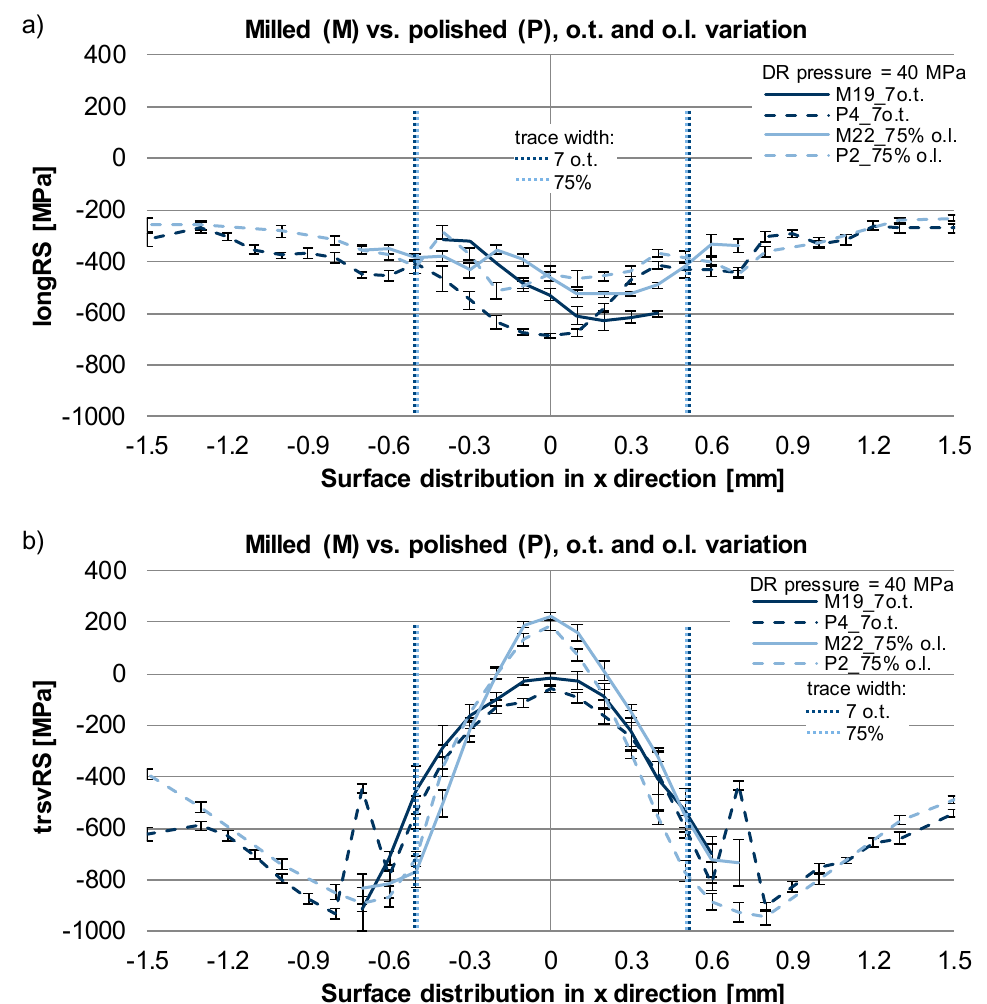
distributions are plotted in Figure 7: Longitudinal direction—Figure 7a and transverse direction— Figure 7b. For both directions, it was expected that RS distribution should be symmetrical to the middle of the DR trace. In longitudinal direction, for two of the specimens (M19 and M22) this was not the case. Here, a lateral shift (up to 200 µm) of the stress profiles was observed, where it is not